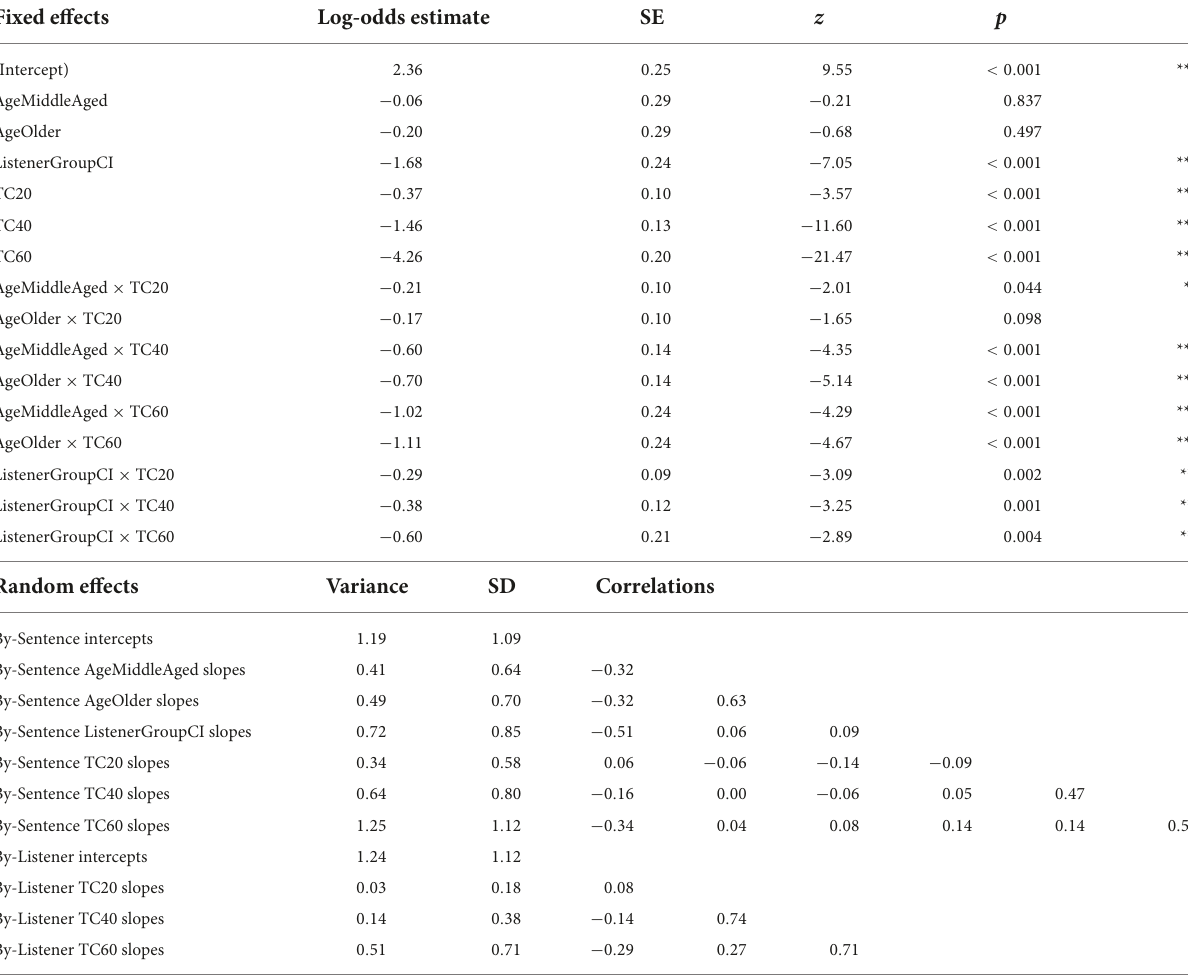
TABLE 4 Logistic mixed-effects model describing the effects of experimental variables and other predictors on recognition performance for time-compressed speech by listeners with CIs and listeners with NH presented a simulation of CI-processed speech (8-channel noise vocoding). Fixed